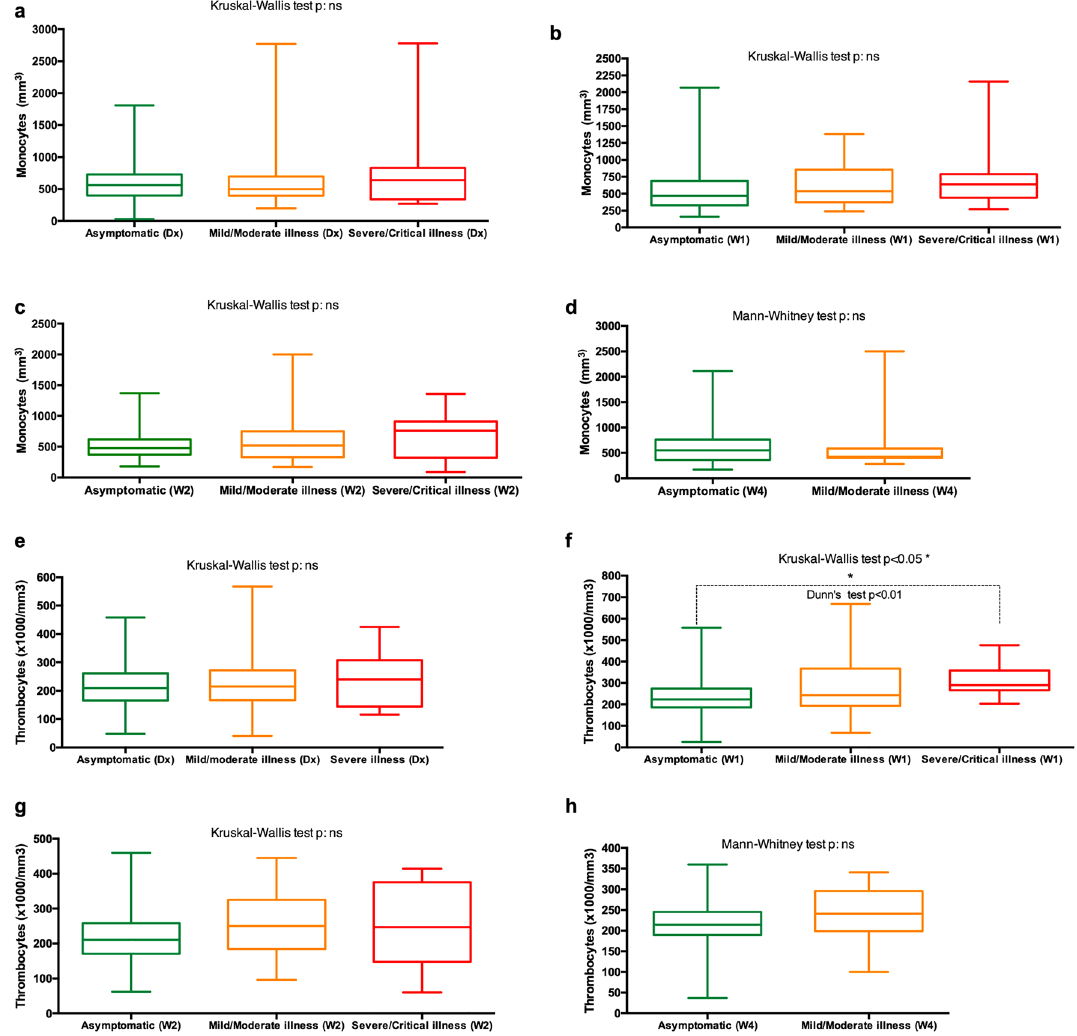
Figure 4. ( a – h ) Temporal changes in the count of monocytes ( a – d ) and thrombocytes ( e – h ) in patients with different COVID-19 severity spectrums. Blood samples were collected and analyzed at diagnosis (Dx), week 1 (W1), week 2 (W2) and week 4 (W4).